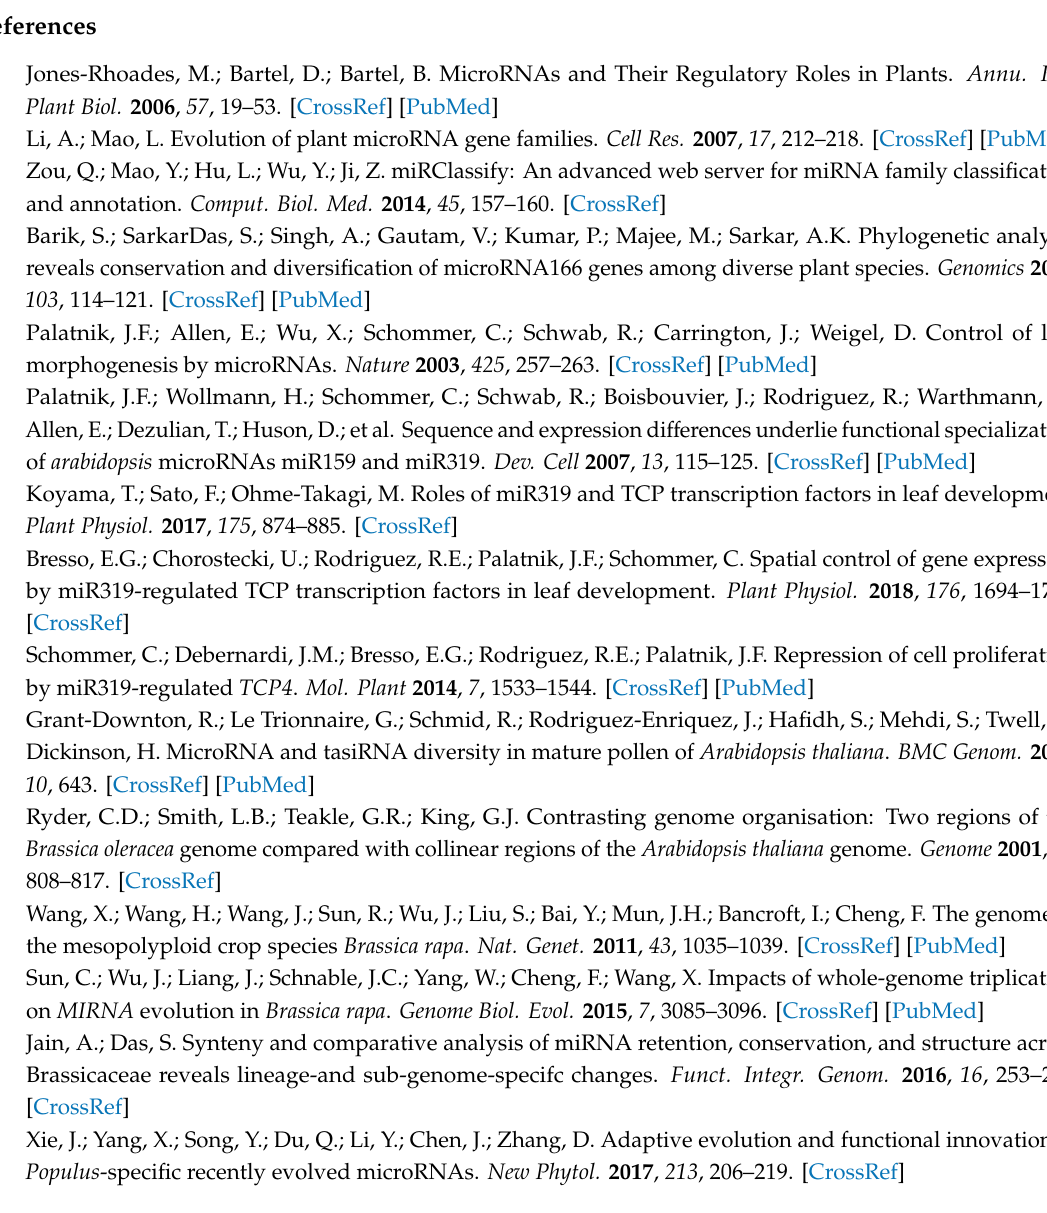
Figure S1: Expression analysis of Bra-MIR319a ; Table S1: Primers used in this